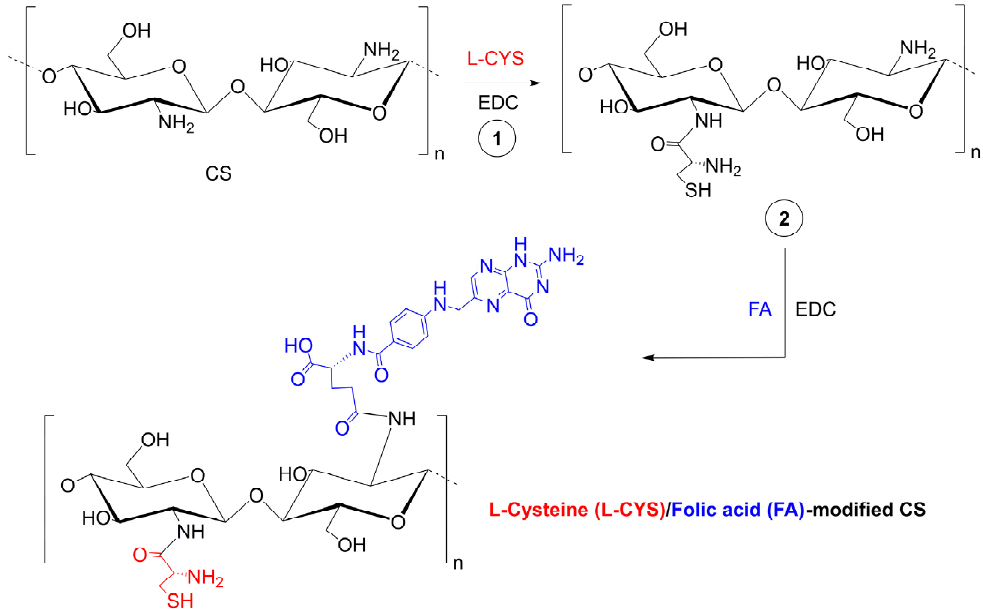
Figure 7. Synthesis of folic-thiolated chitosan in the presence of 1-ethyl-3-(3-dimethylamino propyl) carbodiimide (EDC). Adapted from [67], Pharmaceutics 2020. carbodiimide (EDC). Adapted from [67], Pharmaceutics